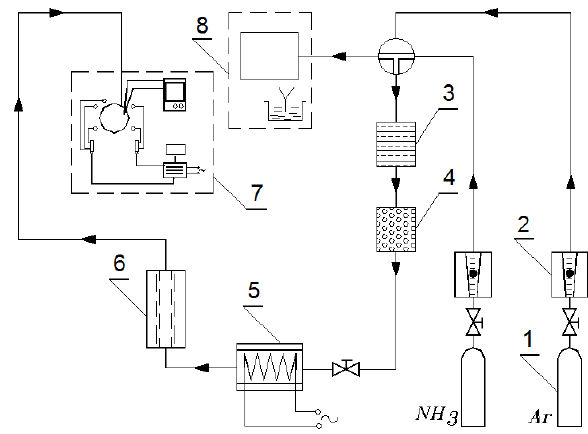
Figure 2. Stand diagram for porous structures